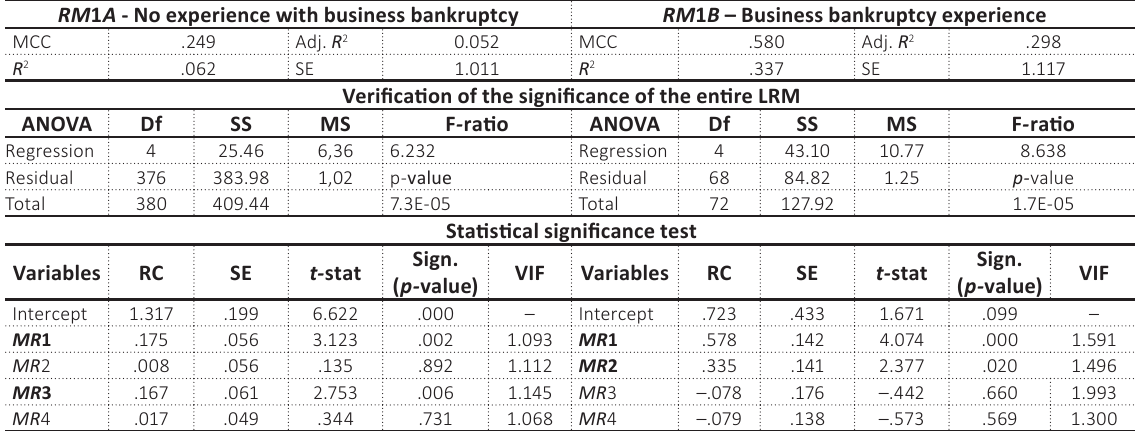
risks (see Table 1). Table 2 summarizes the pairwise coefficients of correlation in the correlation matrices between the indicators of the most significant business risks and the respondents’ ( Y ) perceptions of the future of business. Table 3. The influence of market risk indicators on the perception of the future of business according to the criterion